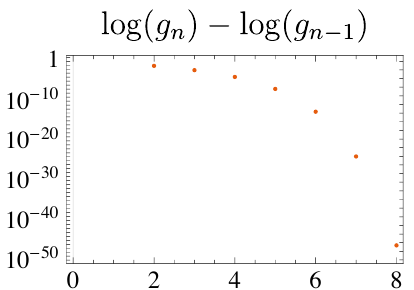
Figure 8 . Fast convergence of Newton’s method. On the vertical axis we plot the difference between consecutive axis. The horizontal axis labels the number of iterations. To be compared with figure 2.